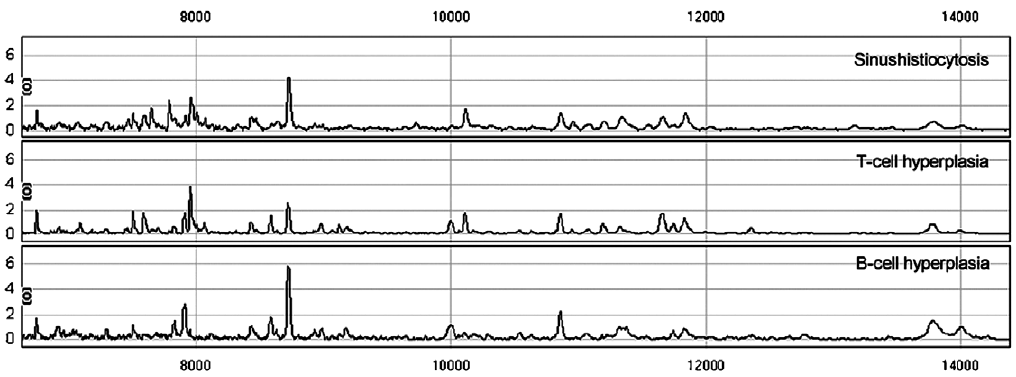
Fig. 7. Comparison of protein profiles from three benign hyperplasia types. Protein profiles were generated from laser micro dissected cells from reactive hyperplasia types often seen in benign lymph nodes: sinus histiocytosis (upper spectrum), paracortical hyperplasia (predominantly T-cells) (middle spectrum), and follicular hyperplasia (mainly B-cells) (lower spectrum). The segment from 7,000–14,000 M/Z is shown here ( Y